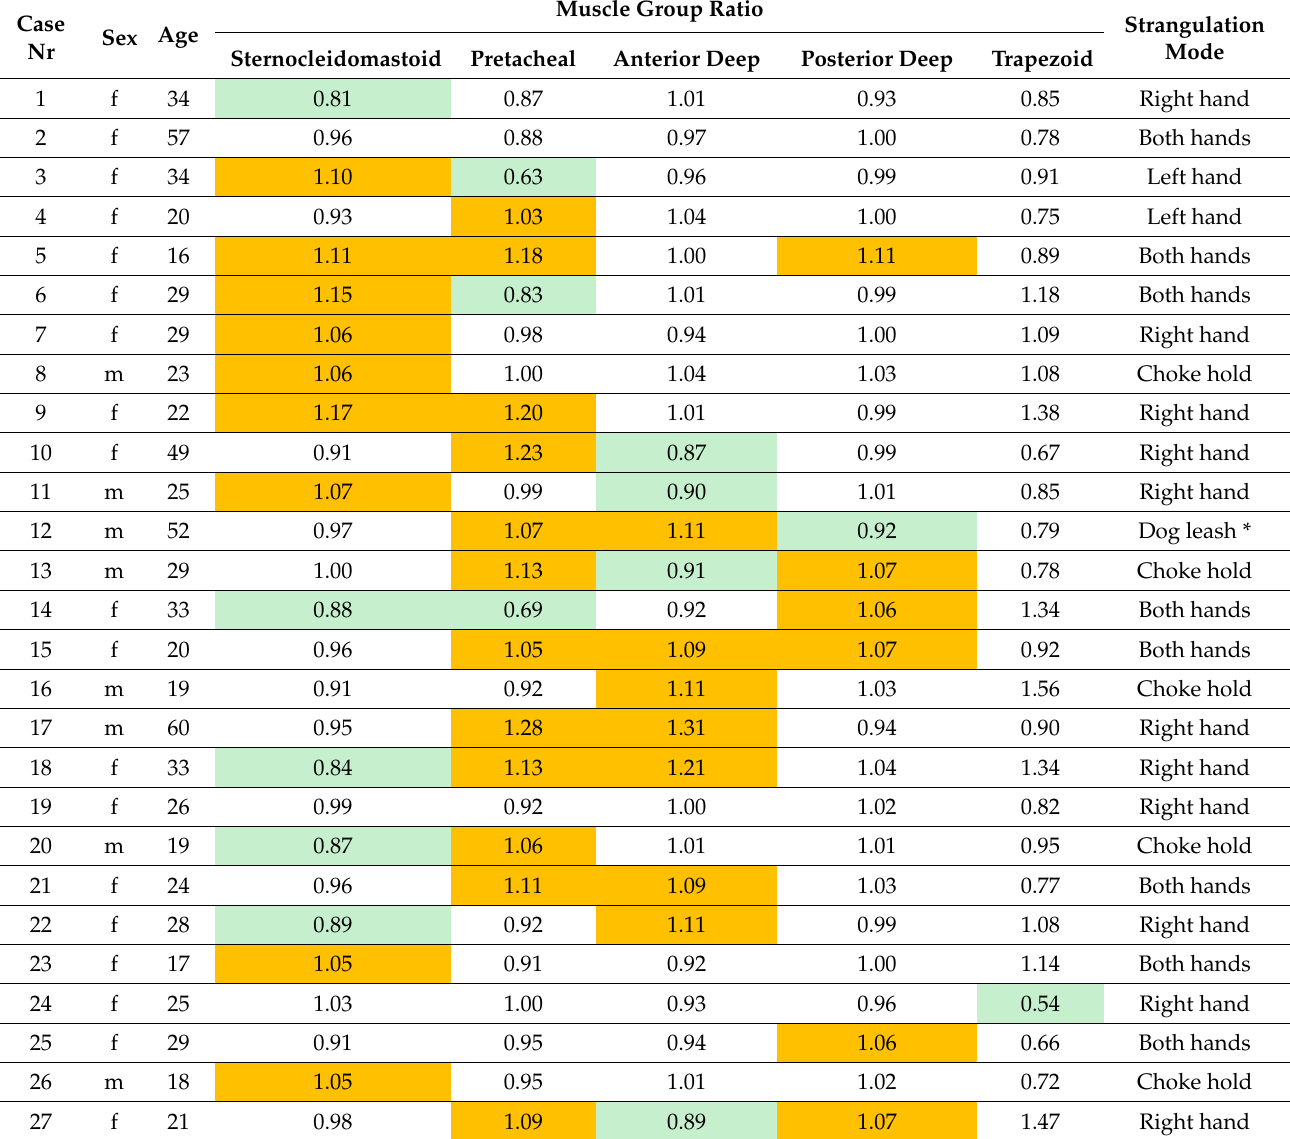
Table 2. All strangulation cases with the ratio of muscle volume (right to left) for each muscle group. Ratios lower than the physiological range of side asymmetry of the cervical muscle volumes are marked in orange, and ratios higher than the physiological range are marked in green. * The single cases of the “dog leash” and “not specified” strangulation modes were not investigated